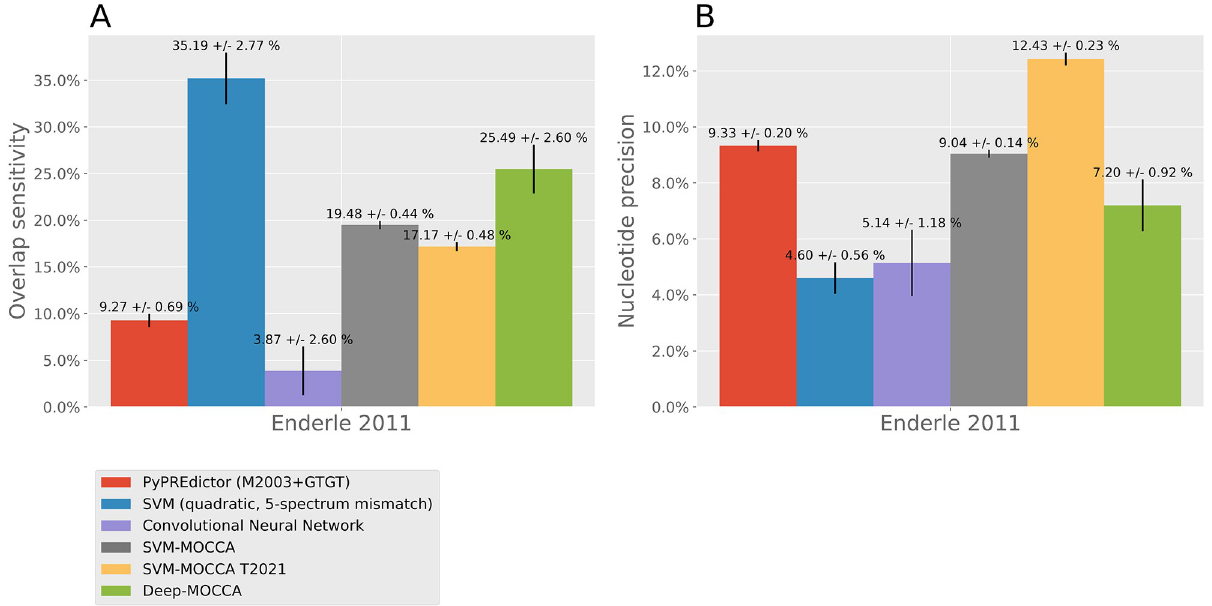
Fig 5. Prediction overlap with experimental data. A) Overlap sensitivity of predictions to Enderle et al. (2011) [35] PREs. B) Nucleotide precision of predictions to Enderle et al. (2011) [35] PREs. In order to avoid bias, for the calculations in both A) and B), we removed PREs from [35] and predictions that were within 1kb of overlapping with a Kahn et al. (2014) [34]